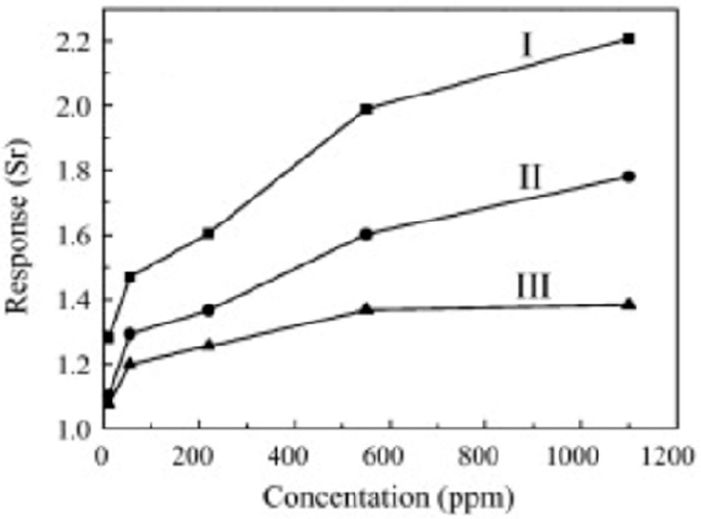
Figure 6. The response of the sensors is based on (I) the ultra-long nanowires, (II) nanowires, and (III) powders of NiO to triethylamine of different concentrations [65].